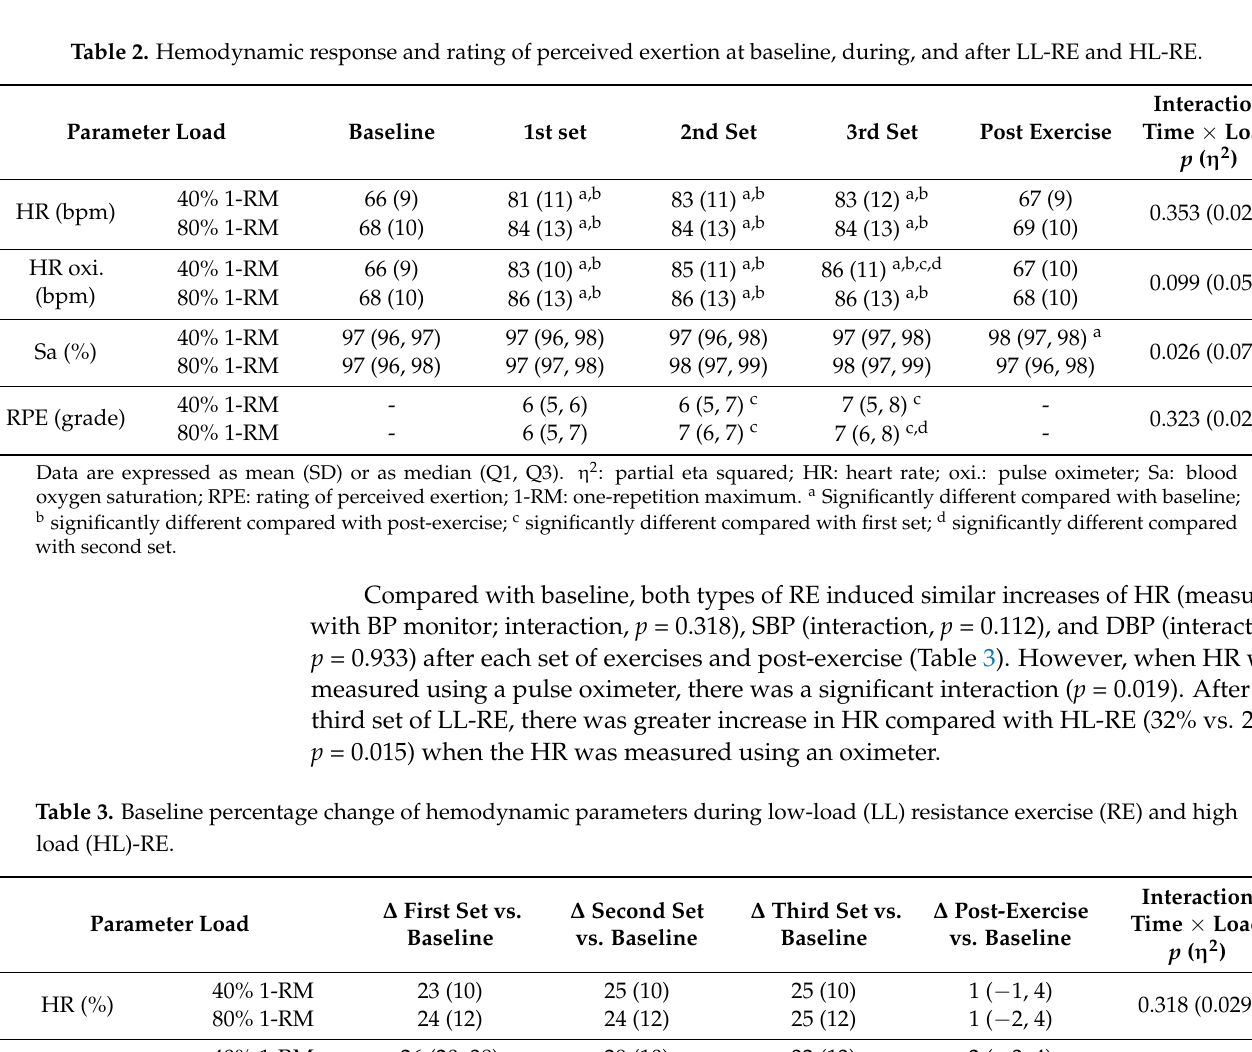
Table 2. Hemodynamic response and rating of perceived exertion at baseline, during, and after LL-RE and HL-RE. Parameter Load Baseline 1st set 2nd Set 3rd Set Post Exercise